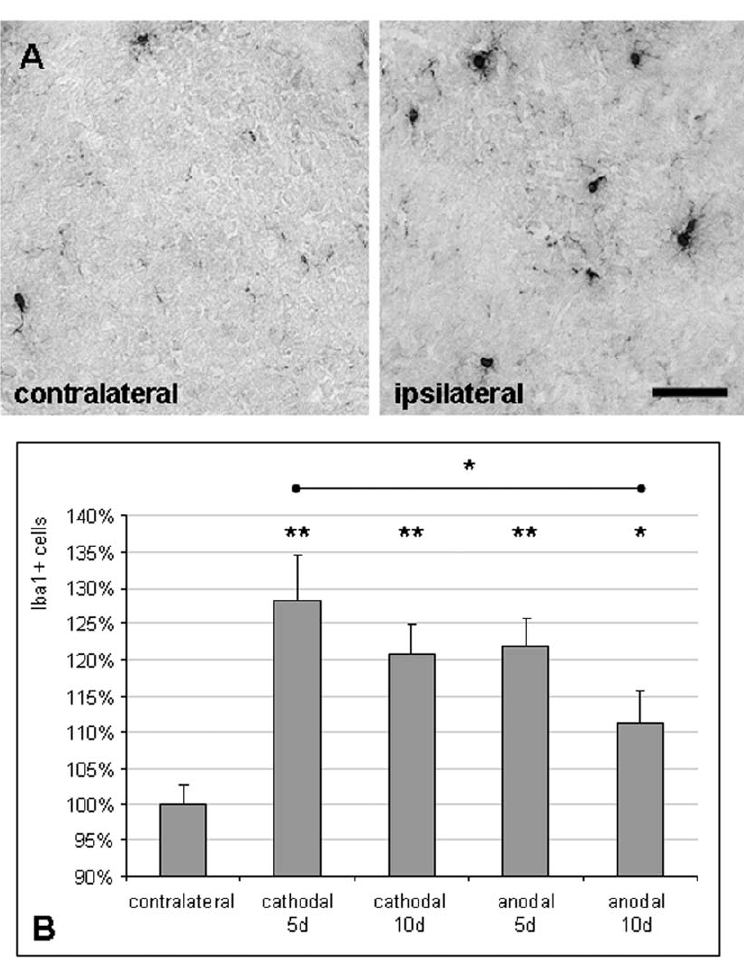
Figure 2. Multi-session tDCS activates cortical microglia. (A) The density of activated microglia identified by Iba1 immunoreactivity was increased in the cortex ipsilateral to multi-session tDCS (scale bar =0.05 mm). (B) This increase in Iba1 + cells compared to the respective contralateral hemisphere was most pronounced early after cathodal tDCS, but also present after anodal stimulation; effects decreased with time (means 6 SEM; *p=0.05, **p ,